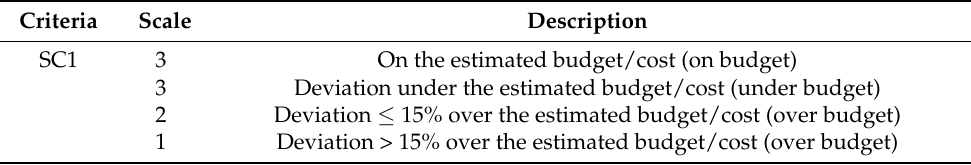
Table 1. Project Success Criteria and